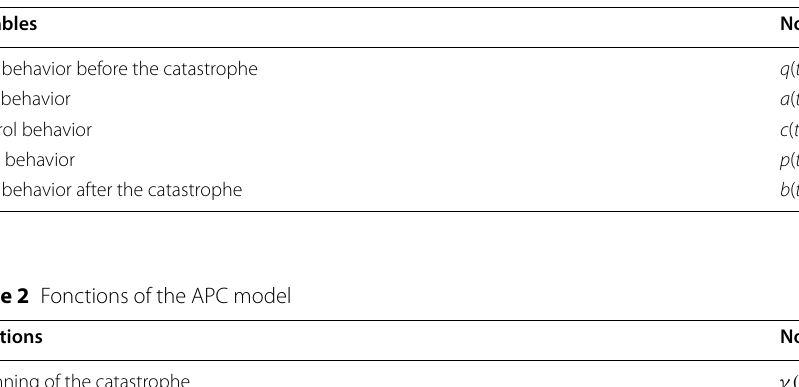
Table 1 Variables of the APC model